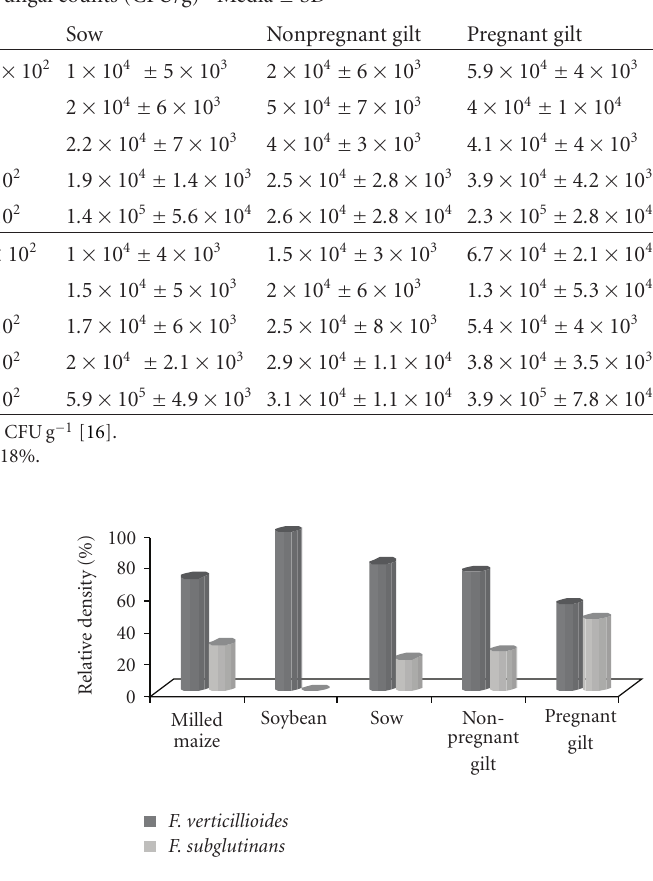
Figure 3: Relative density (%) of Fusarium spp. isolated from raw materials and finished feed for sow at di ff erent reproductive